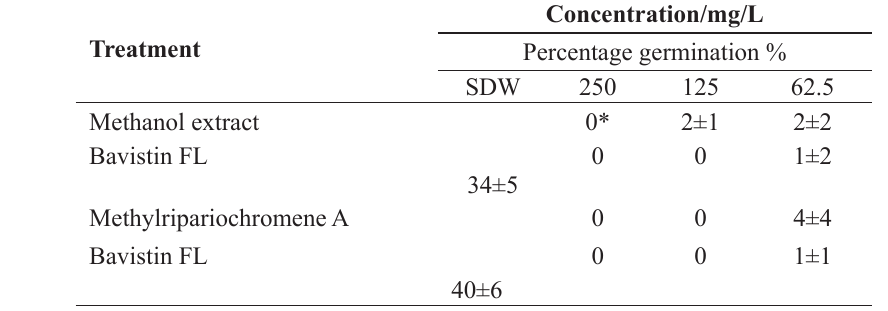
Table 1: Percentage germination of conidia of Colletotrichum musae .